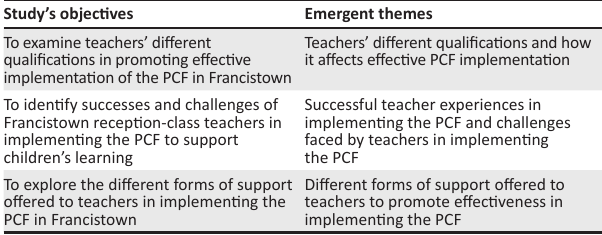
TABLE 1 : Presentation of the study’s objectives and emerged